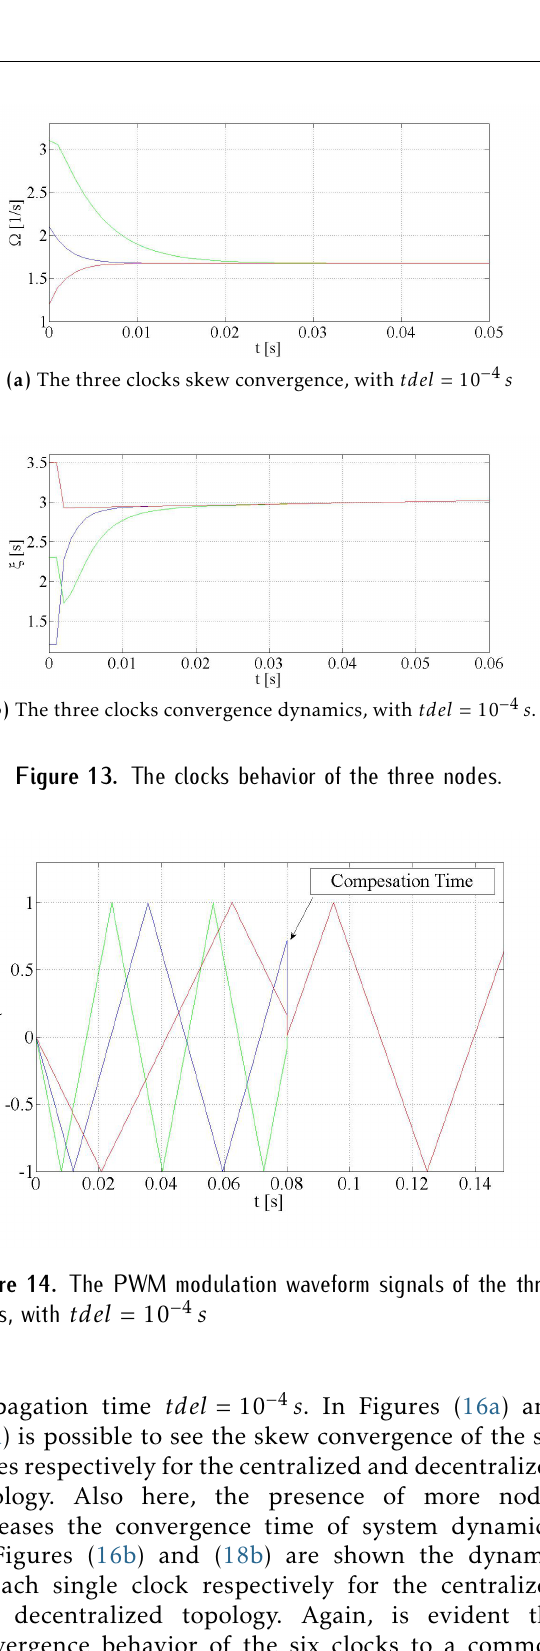
propagation time tdel = 10 − 4 s . In Figures (16a) and (18a) is possible to see the skew convergence of the six nodes respectively for the centralized and decentralized topology. Also here, the presence of more nodes increases the convergence time of system dynamics.